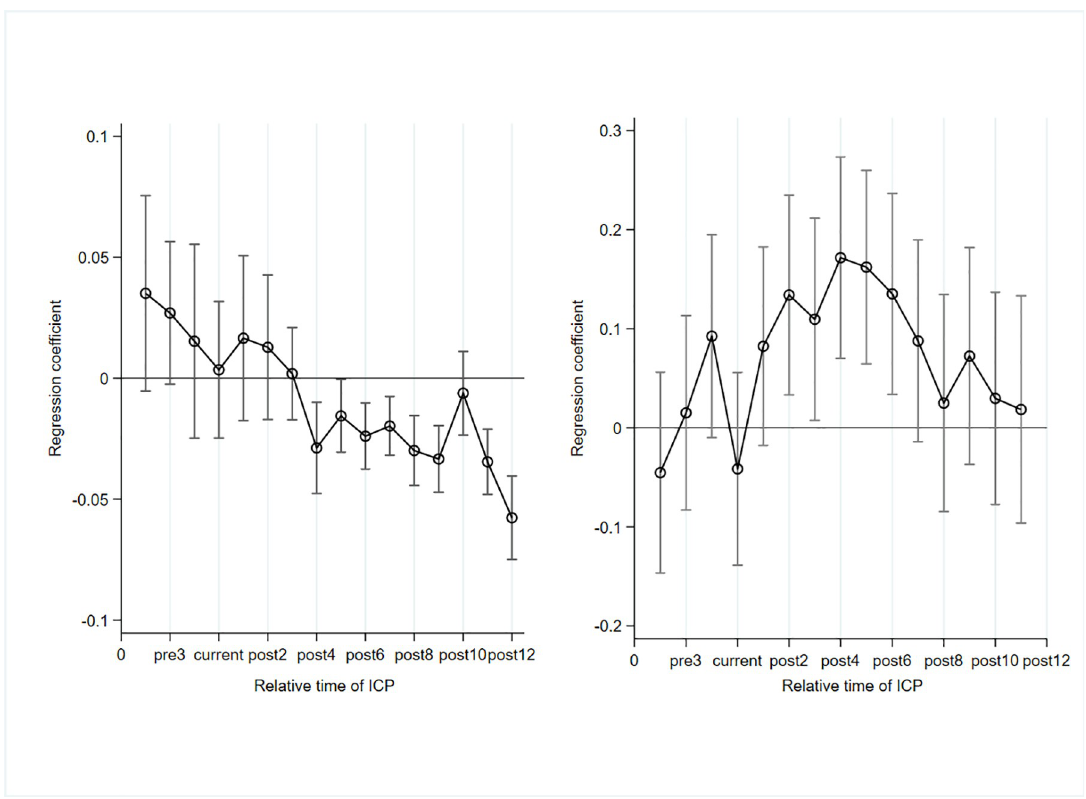
Fig 3. Dynamic evolution of the convergence effect and basic